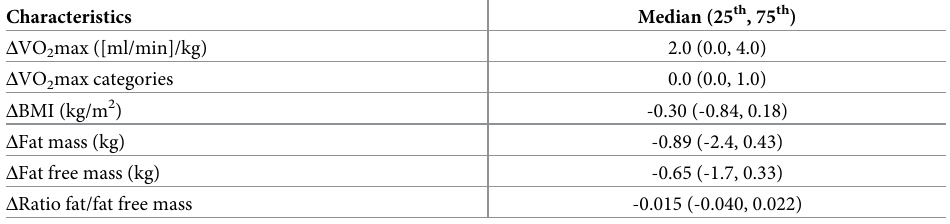
Table 2. Change (follow-up—Baseline, Δ ) in metabolic markers during intervention.